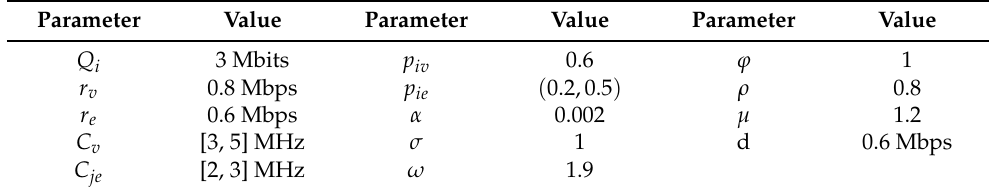
Table 3. The simulation parameters.